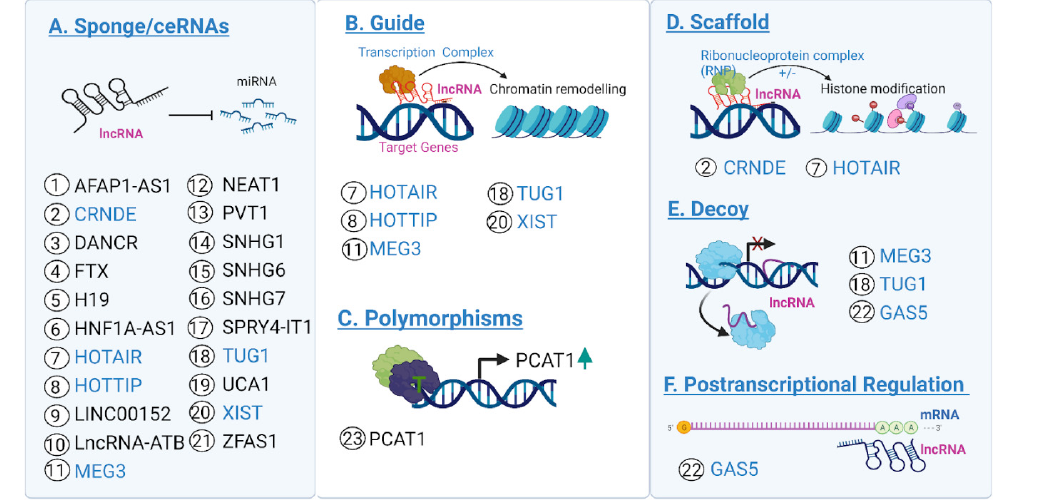
Figure 1. lncRNAs in CRC. Schematic description of the most frequent mechanisms of action (from A–F) reported for the list of the candidate lncRNAs biomarkers (indicated by numbered circles) listed in Table 2, with strong supporting evidence in CRC. Highlighted in blue are the names of the lncRNAs with more than one mechanism reported. Created using Biorender.com.